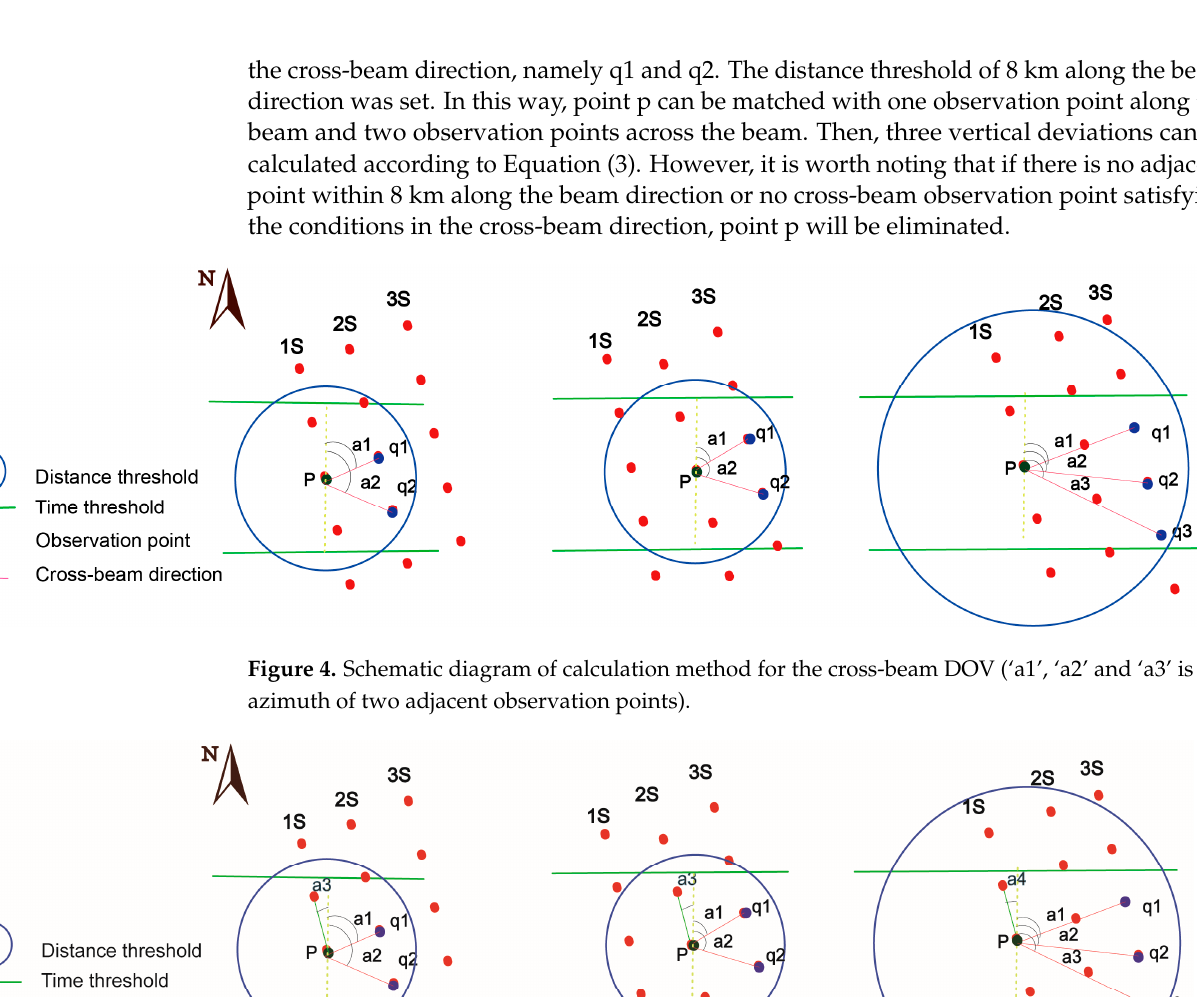
Figure 5. Schematic diagram of calculation method for the joint along-cross beam DOV (‘a1’, ‘a2’, ‘a3’ and ‘a4’ is the azimuth of two adjacent observation points).